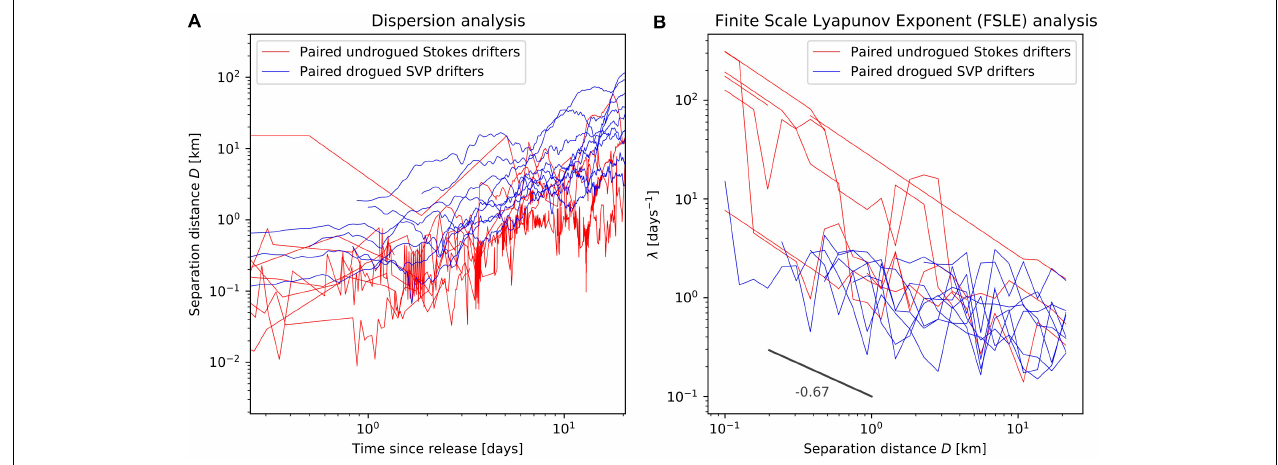
FIGURE 6 | Pair-wise dispersion analysis for the undrogued Stokes (red) and drogued SVP (blue) drifters, shown both as separation-with-time [panel (A) ] and as Finite Scale Lyapunov Exponent [FSLE, panel (B) ] analyses, for the first 20 days after deployment.